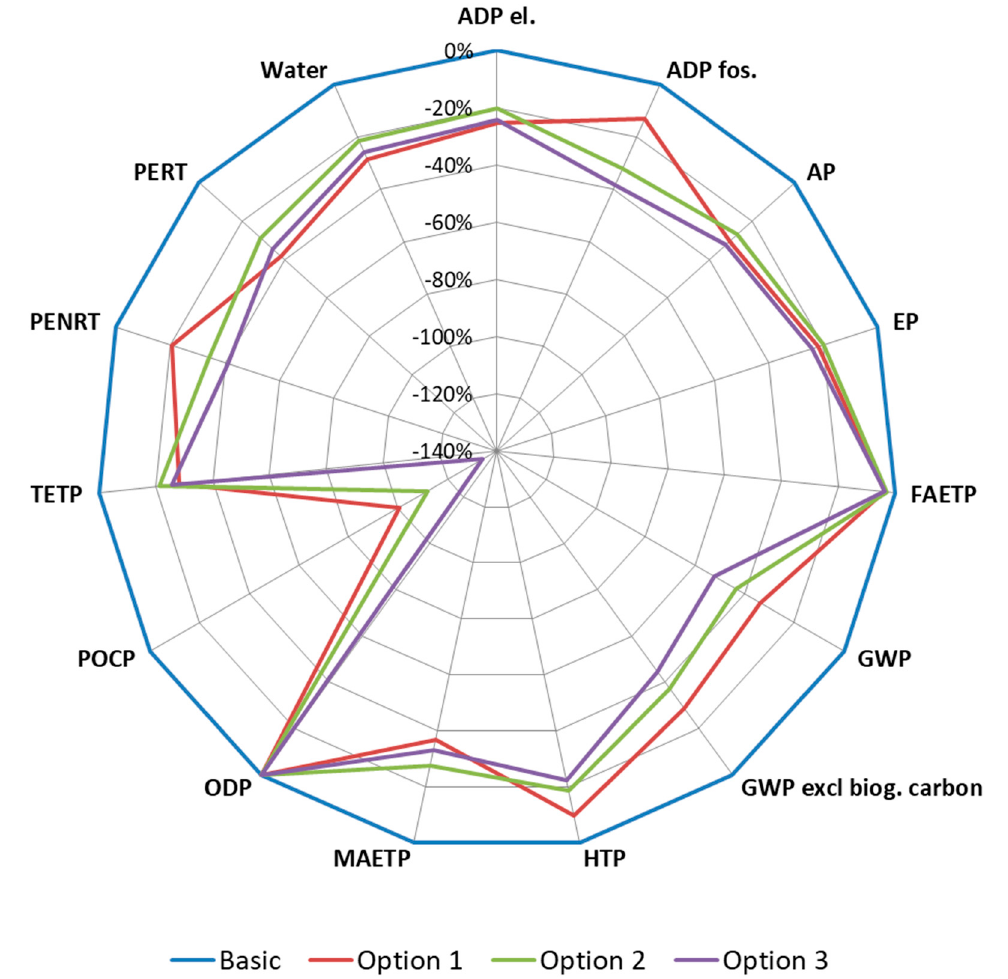
Figure 6. The decrease in the environmental burden for different heat generation scenarios